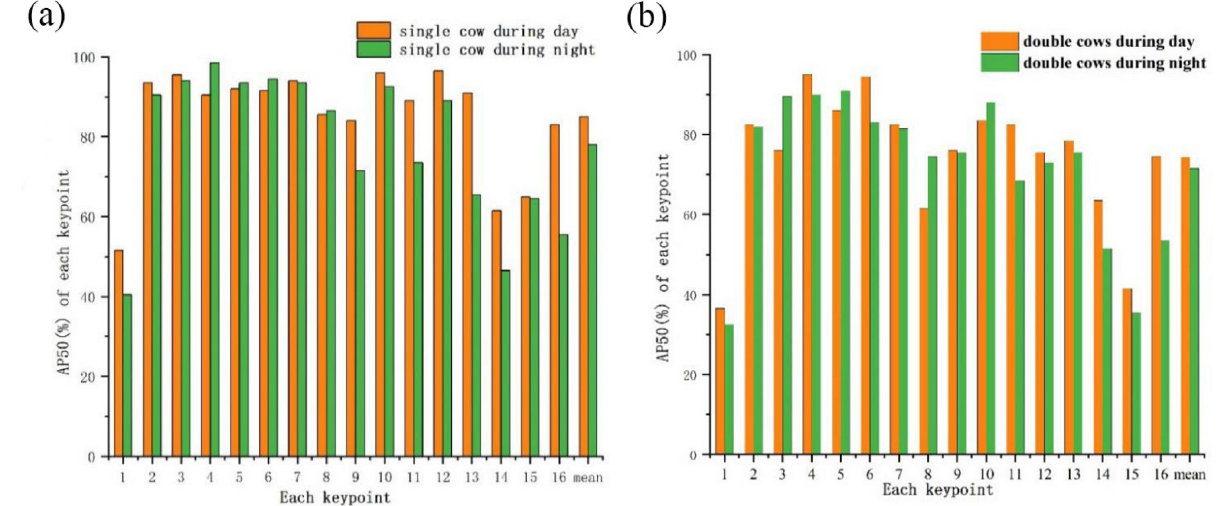
Fig 6. Average precision of all keypoints. (a) All keypoints of single cow. (b) All keypoints of double